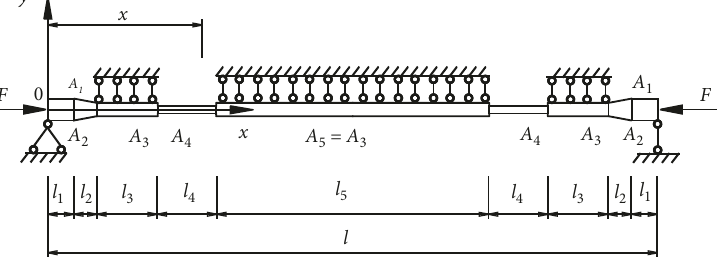
Figure 2: Mechanical model of the core.